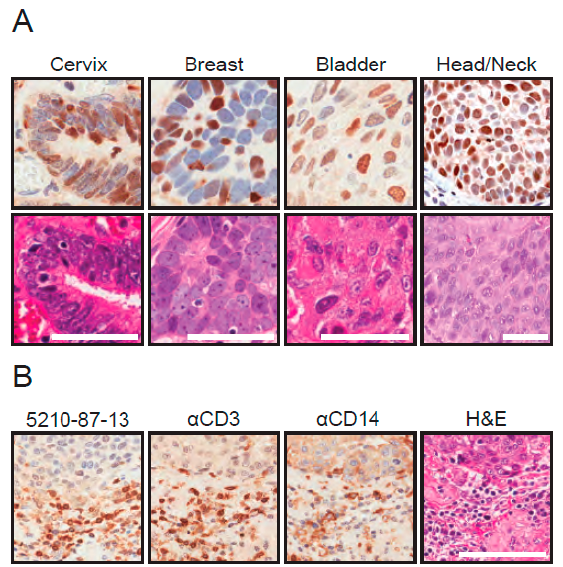
Figure 5. IHC detection of endogenous A3B protein in tumors using the 5210-87-13 mAb: ( A ) 5210- 87-13 mAb staining of the indicated FFPE tumor specimens prescreened by RTqPCR for high A3B mRNA levels (top row). A hematoxylin-stained serial section is shown below each tumor (scale bars are 50 µm). ( B ) 5210-87-13 mAb, anti-CD3, and anti-CD14 staining of a representative FFPE tumor specimen with inflammation and infiltrating immune cells (scale bar is 100 µm). See text for